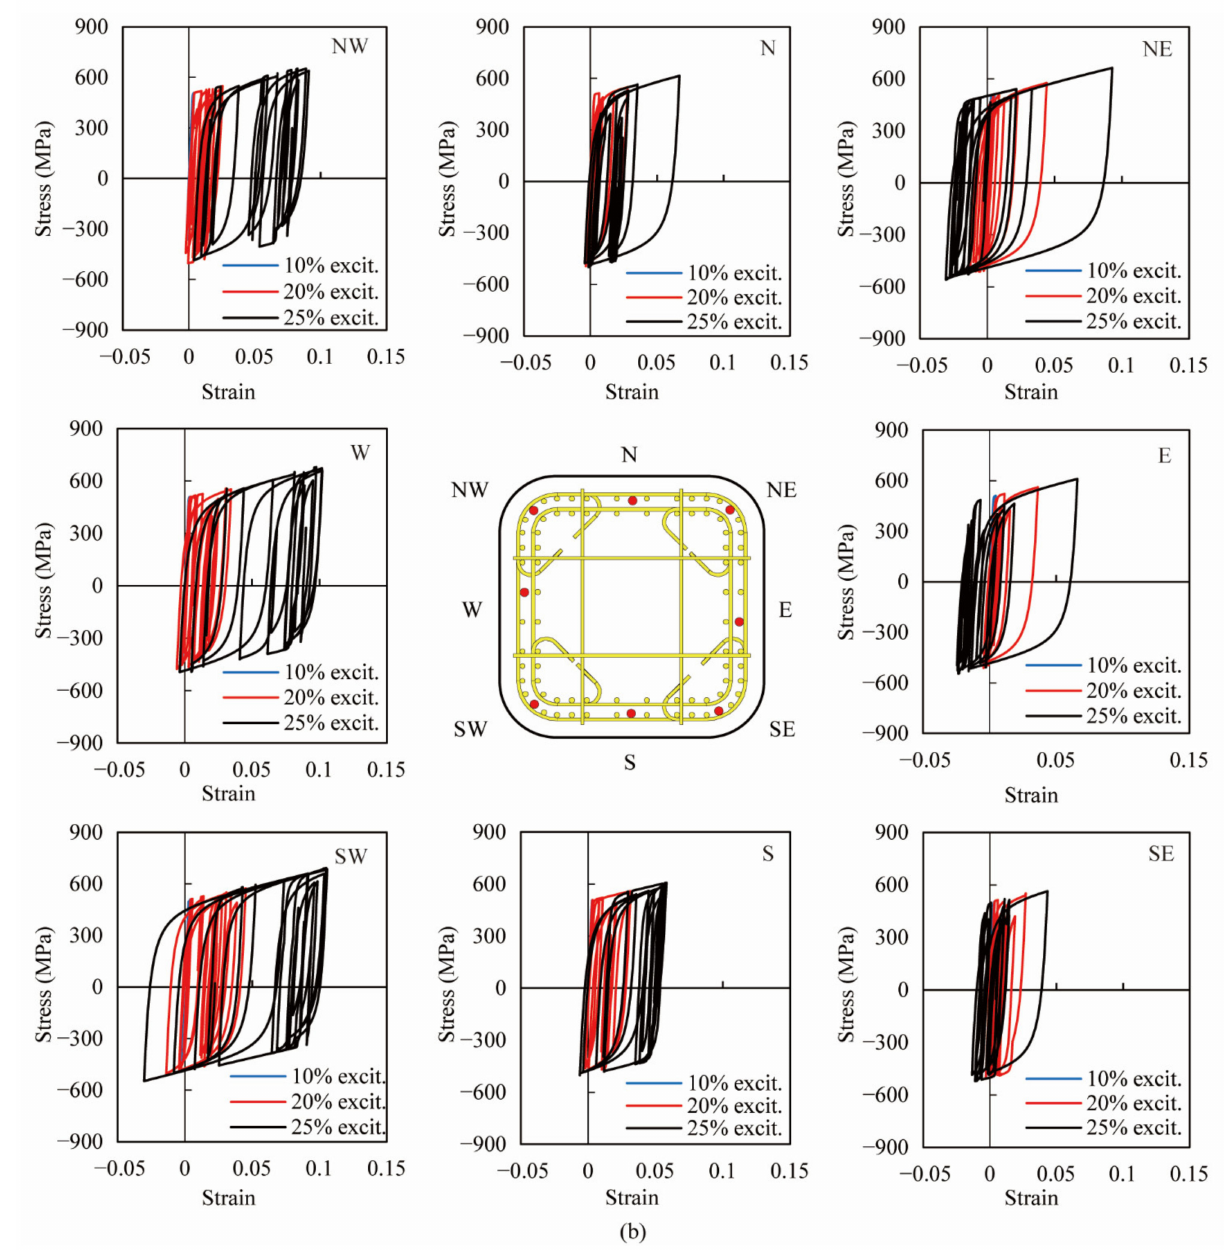
Figure 14. Analytical hysteresis of stress-strain in longitudinal bars at the column base. ( a ) PFRC-1, ( b )